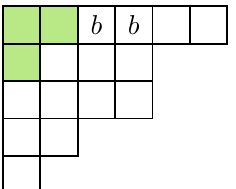
˜ λ b for either of the boxes marked b